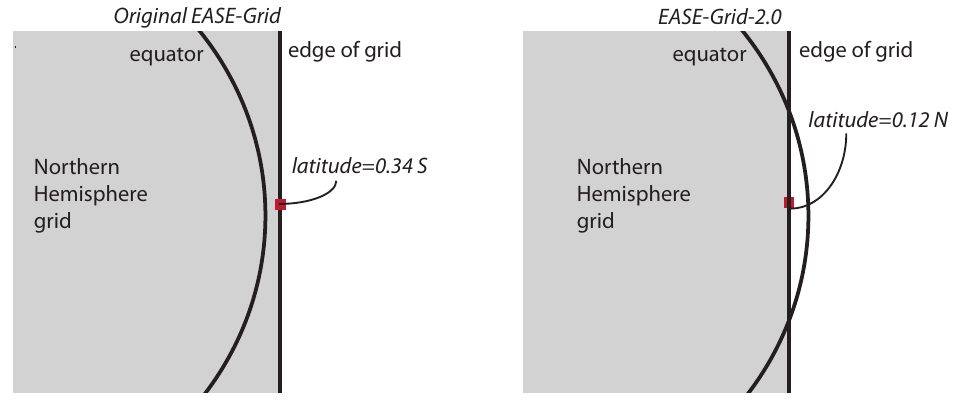
Figure 6. Relationship of equator to right edge of grid coverage in Northern Hemisphere azimuthal 25-kilometer original EASE-Grid (( Left ), equator enclosed within spatial coverage) vs . EASE-Grid 2.0 (( Right ), equator slightly outside spatial coverage). Southern Hemisphere grids are defined likewise. Curvature of equator is greatly exaggerated relative to edge of grid.